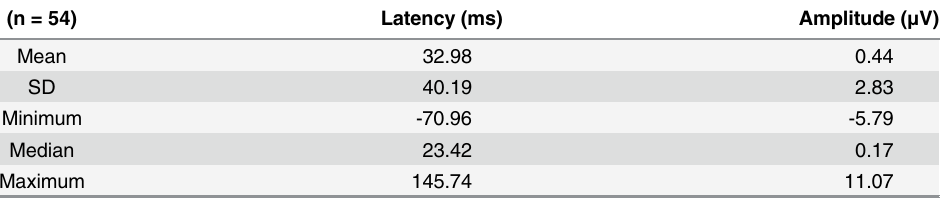
Table 5. Descriptive statistics of the difference between the values obtained with and without noise (with noise minus without noise) for P300 latency (ms) and amplitude ( μ V) measures. (n = 54) Latency (ms) Amplitude ( μ V) Mean 32.98 Minimum Median